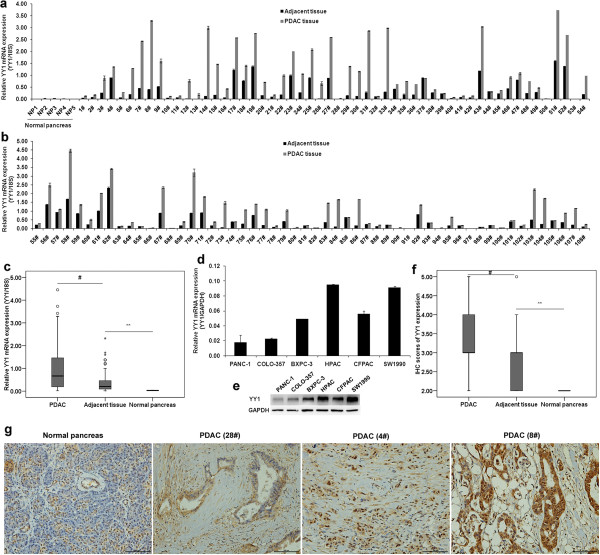
YY1 expression in PDAC tissues and cell lines. (a, b) qRT-PCR analysis of YY1 expression in five normal pancreas tissues and 108 pairs of PDAC tissue and adjacent tissue. YY1 expression in the normal pancreas tissues was low, but was slightly higher in the tissue adjacent to PDAC tumors and significantly higher in the PDAC tumors themselves. Of the 108 paired tissues, YY1 expression was higher in the cancer tissue than in the adjacent tissues in 86 cases (p < 0.05). (c) A boxplot showing the qRT-PCR results of YY1 mRNA expression in the 108 cancer tissue, 108 adjacent tissue and five normal pancreas tissues (mean ± SD: 1.01 ± 1.01, 0.38 ± 0.43 and 0.03 ± 0.01, respectively). The bottom and the top edges of the box mark the lower boundary and upper boundary of the 95% confidence interval (CI) for the mean. The center horizontal line is drawn at the sample mean. The center vertical lines drawn from the boxes extend to the minimum and the maximum. (d) qRT-PCR analysis of YY1 expression in six PDAC cell lines. (e) Western blotting of YY1 expression in six PDAC cell lines. (f) A boxplot showing the immunohistochemistry (IHC) results of YY1 protein expression in the 108 cancer tissue, 108 adjacent tissue and five normal pancreas tissues. (g) IHC showing the location of YY1 in PDAC samples. Scale bar, 100 μm. (** represents p < 0.01, # represents p < 0.001, compared with the control group).